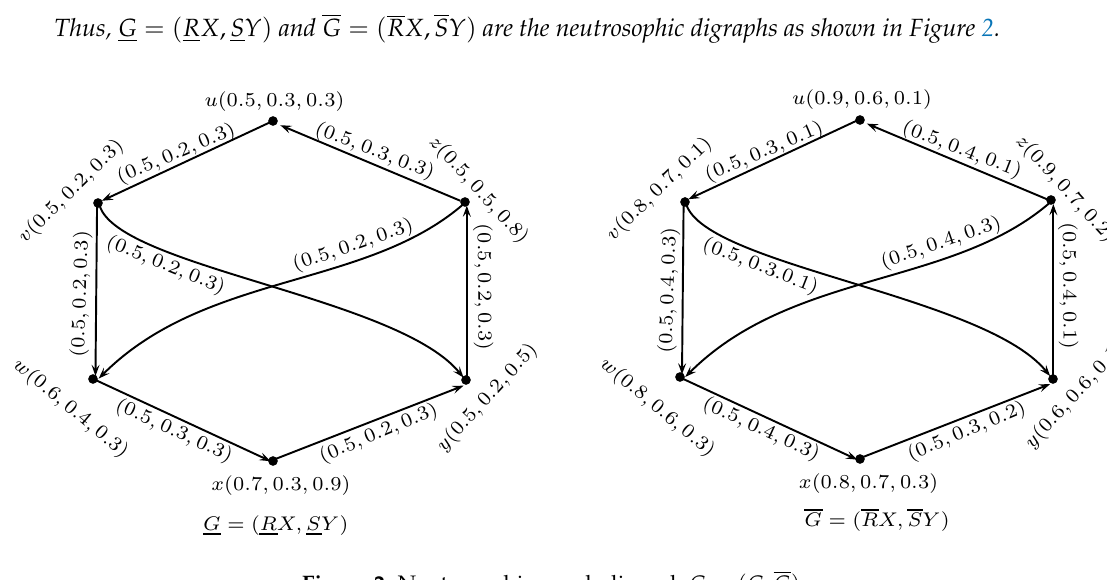
Figure 2: Neutrosophic Rough Digraph G = ( G, G ) Figure 2. Neutrosophic rough digraph G = ( G , G )